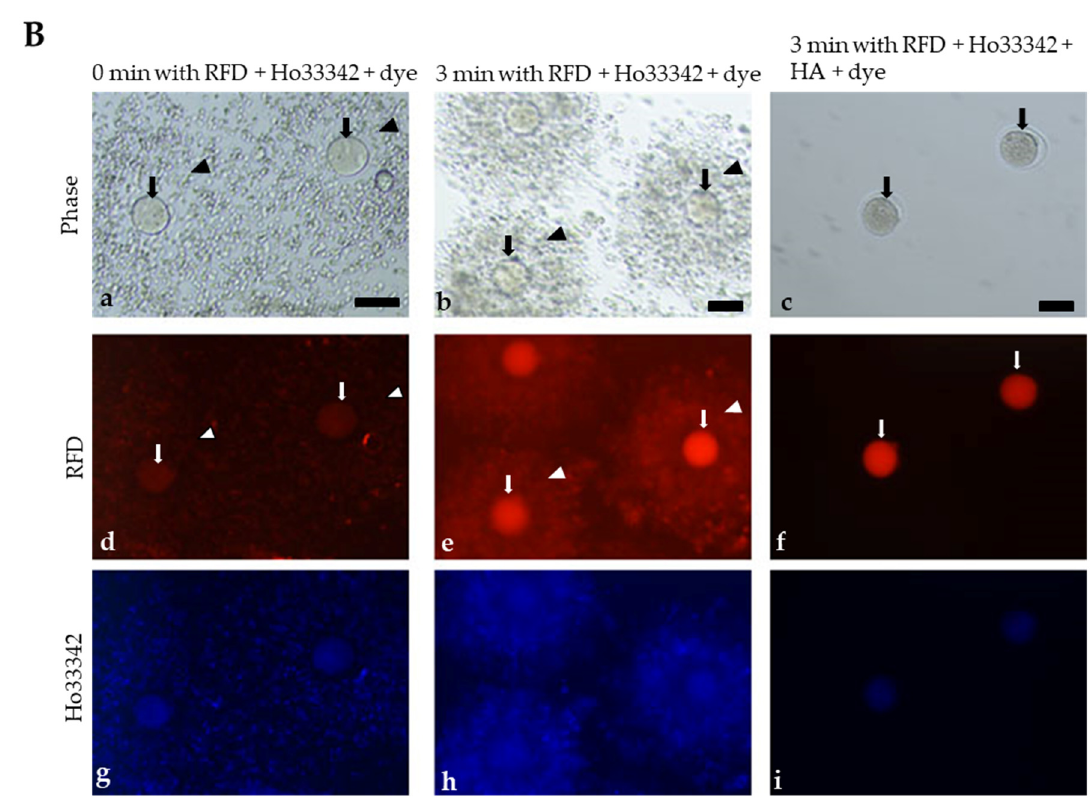
Figure 4. Visualization of successful i -GONAD at early zygote stage. ( A ). Schematic representation of intraoviductal injection of a solution containing fluorescent substances at 10:30 a.m. on the day when vaginal plug was discerned for checking possible fluorescence in zygotes and cumulus cells. In vivo EP was performed immediately (0 min) or 3 min after intraoviductal injection of a solution containing tetramethylrhodamine-conjugated dextran 3 kDa (RFD) + Hoechst 33342 (Ho33342) + Fast Green FCF (dye) (which is called “RFD + Ho33342 + dye”). In some cases, in vivo EP was performed 3 min after intraoviductal injection of a solution containing RFD + Ho33342 + hyaluronidase (HA) + dye. After in vivo EP, oviducts are dissected and subjected to isolation of a cumulus–zygote complex or cumulus cell-free zygotes for checking fluorescence. ( B ). Fluorescence inspection in the cumulus–zygote complex or cumulus cell-free zygotes isolated from the i -GONAD-treated females at 10:30 a.m. Note that when in vivo EP 0 min after intraoviductal injection of RFD + Ho33342 + dye was performed, no obvious RFD-derived fluorescence was discernible in zygotes (arrows in d ), although a slight fluorescence was seen in the attached cumulus cells (arrowheads in d ). In contrast, bright RFD- derived fluorescence was discernible in both zygotes (arrows in e ) and cumulus cells (arrowheads in e ) when in vivo EP 3 min after intraoviductal injection of RFD + Ho33342 + dye was performed. In vivo EP 3 min after intraoviductal injection of RFD + Ho33342 + HA + dye resulted in generation of cumulus cell-free zygotes with bright RFD-derived fluorescence (arrows in c,f ). Bar: 100 µ